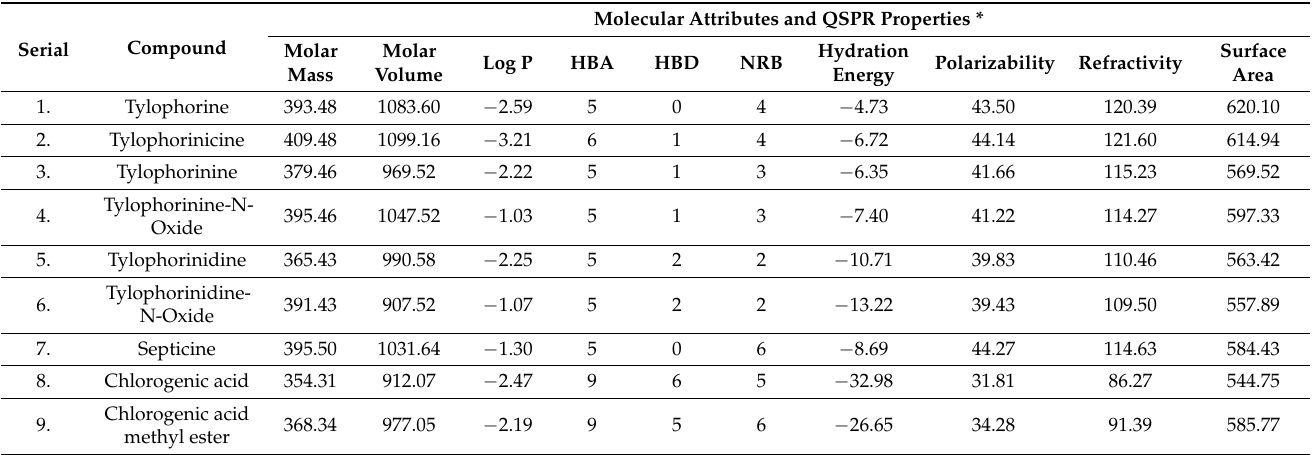
Table 1. Molecular properties of the Tylophora indica isolated